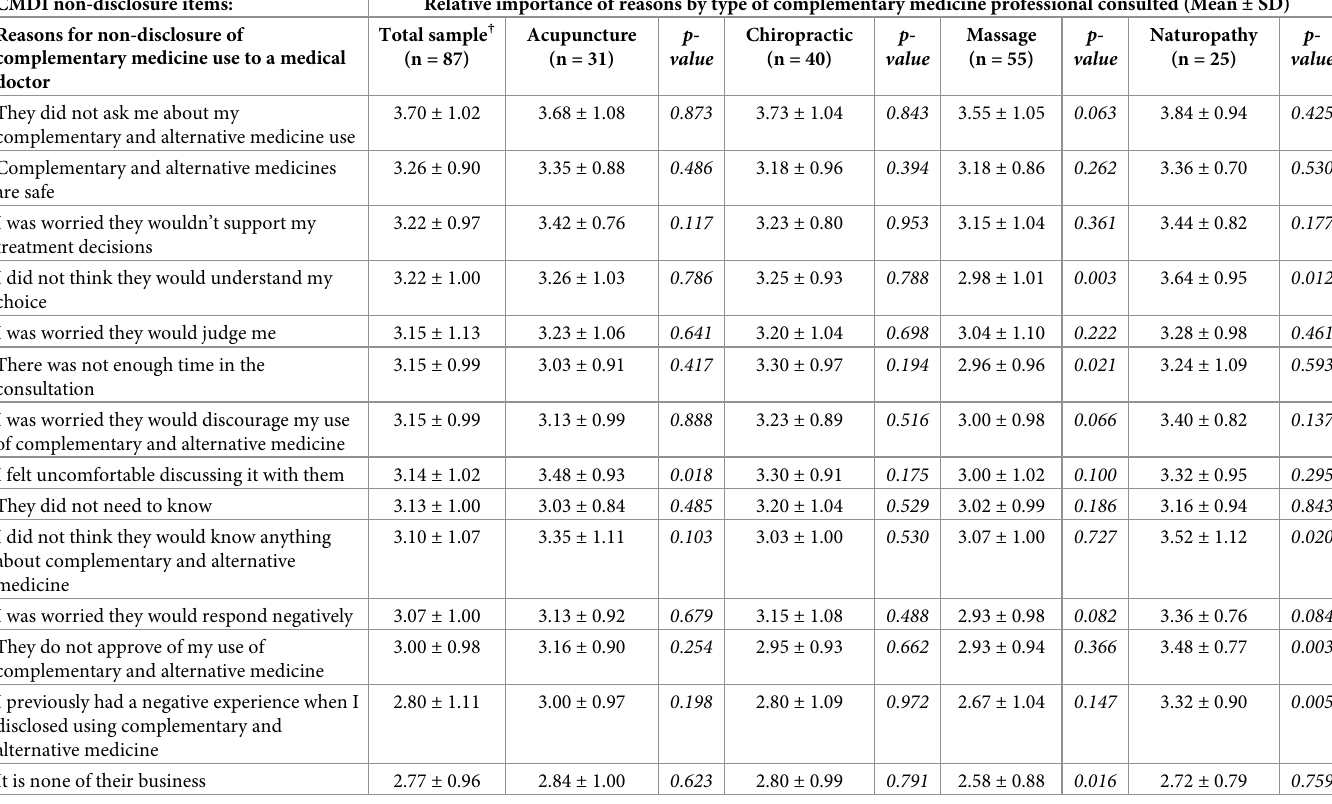
Table 4. T-test showing differences in reasons for non-disclosure of complementary medicine use to medical doctors for each type of complementary medicine pro- fessional